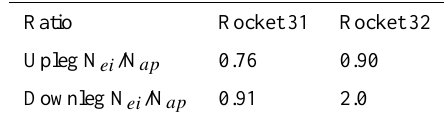
Table 1. Comparison of plasma probe and radio beacon derived peak densities.